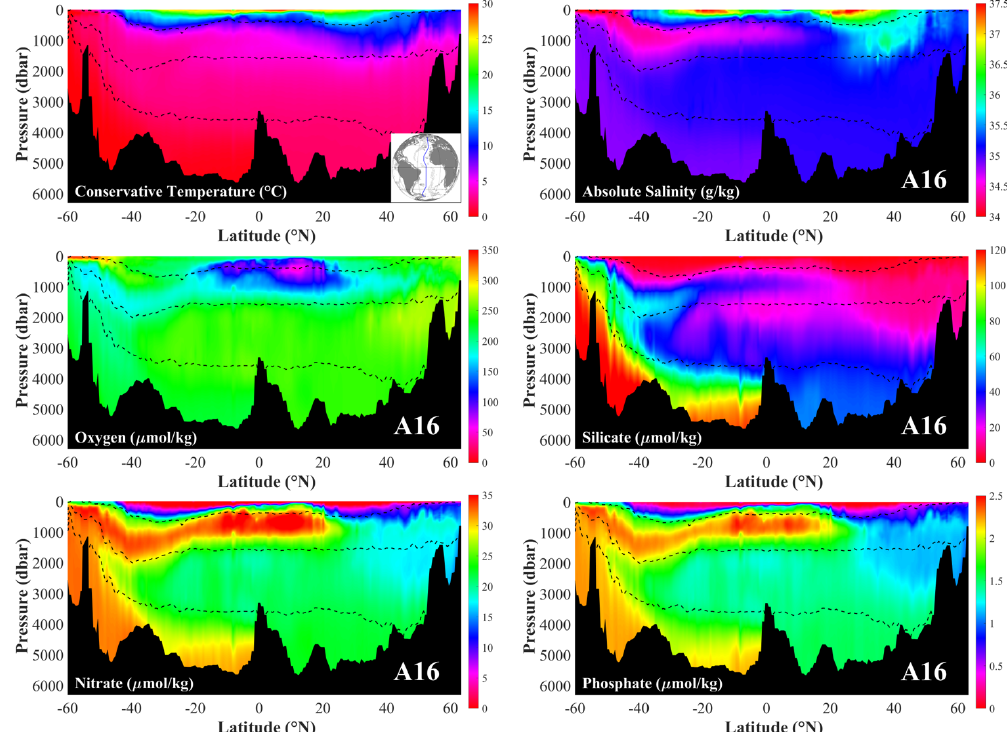
Figure 1. The Atlantic distribution of key properties required by the OMP analysis along the A16 section as occupied in 2013 (expo code: 33RO20130803 in North Atlantic and 33RO20131223 in South Atlantic). The dashed lines show the neutral densities at 27.10, 27.90 and 28.10kgm − 3